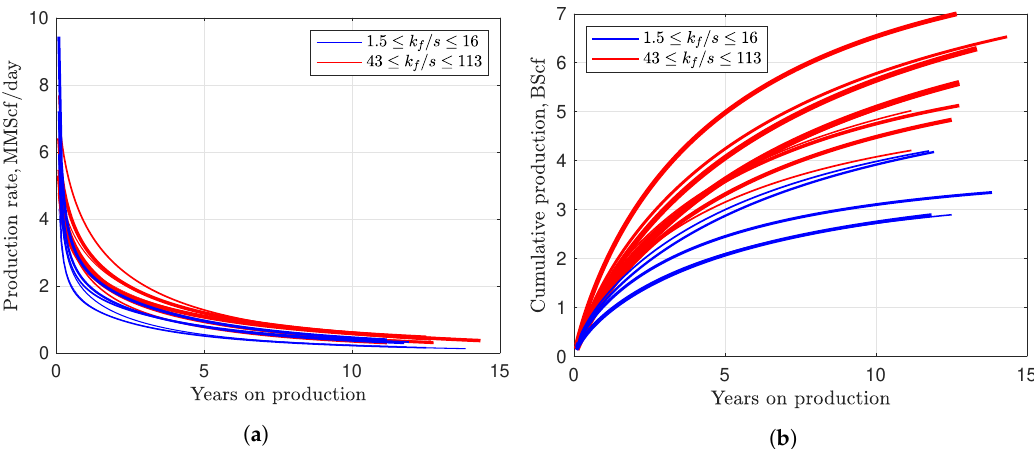
Figure 9. Gas production rate ( a ) and cumulative production ( b ) depend on the ratio k f / s . The thickness of each line increases with the increasing k f / s . This ratio represents the contributions from the macroscale and microscale discharge processes. For the low values of this ratio, initial production rate can be very high with a steep production decline (blue curves). Faster production decline caused by the low k f / s gives lower ultimate cumulative production. The two sets of curves do not increase monotonically with k f / s , because of uncertainty in the initial mass in place, which depends on the porosity, gas saturation and the stimulated volume after